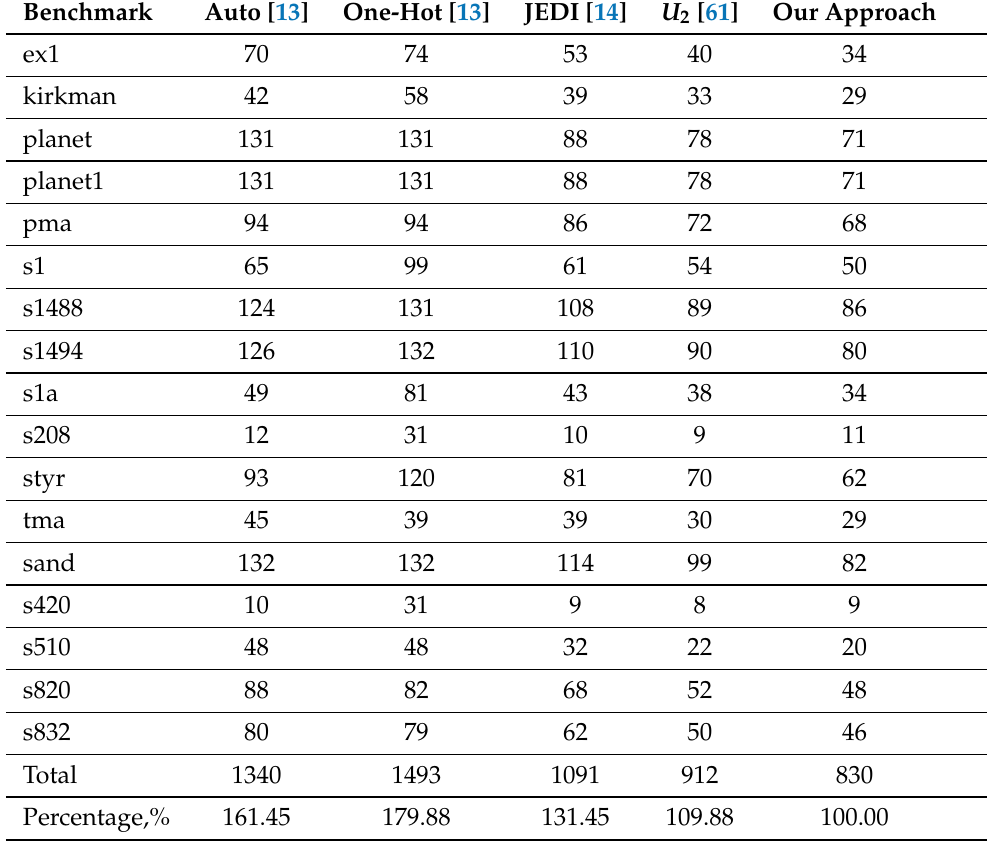
Table 11. Experimental results (LUT counts for benchmarks of G2–G4).